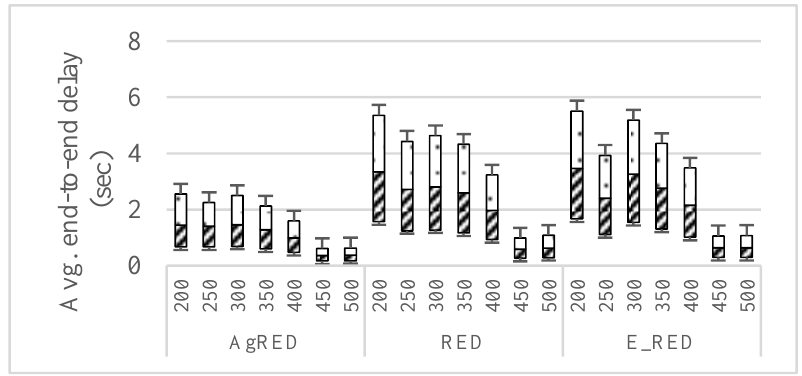
Figure 12. Box plot for average end-to-end delay (UDP) vs. number of nodes in AgRED. This graph is evidence that overall delay performance is almost doubled in the ma- jority of scenarios expanding from 200 nodes to 400 nodes. The higher number of nodes, e.g., 450 and 500, represents a major improvement in all three techniques caused by the routes created by the routing protocol AODV, which benefits from the larger number of nodes in the vicinity. Thus, a shorter route is formed and delay is minimized. It is believed that the routing protocol selected will play an important role in estimating delays regard- less of the AQM technique used [46], but regardless of the routing protocol used, AQM techniques will offer improved end-to-end delays with the same routing protocol in con- gested networks by managing queues to help queue overflows. The throughput of AgRED, RED, and E_RED is presented in Figure 13a, highlighting that the overall throughput of AgRED surpasses RED and E_RED by a great margin. In the mentioned graph, AgRED performs 49.5% better as compared to RED and 44.8% better as compared to E_RED. Generally, higher throughput is achieved in all three techniques where the number of nodes is between 450 and 500.